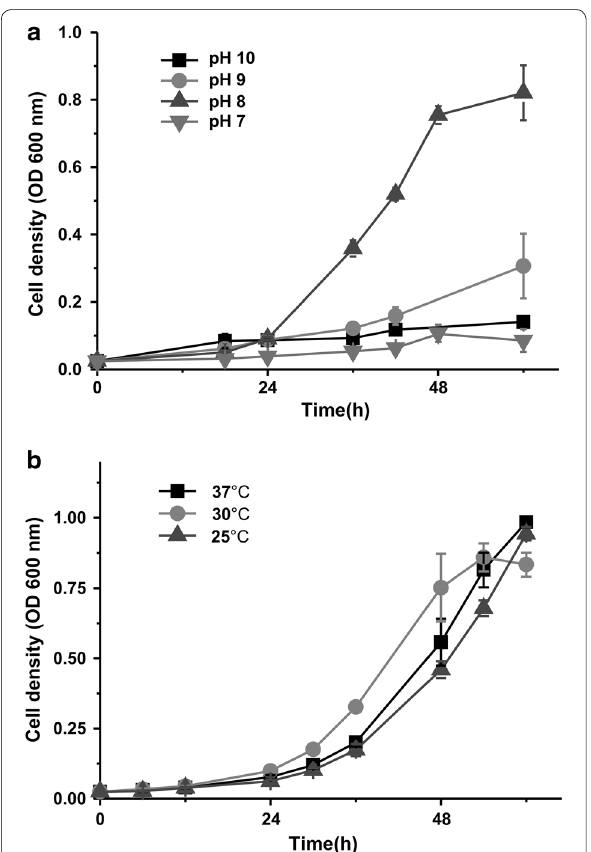
Fig. 3 Effect of pH and temperature on cell growth of strain DW-1 in MSM with 3-hydroxypyridine. a pH dependent growth of strain DW-1. b Temperature dependent growth of strain DW-1. Each value is the mean from three parallel replicates ±